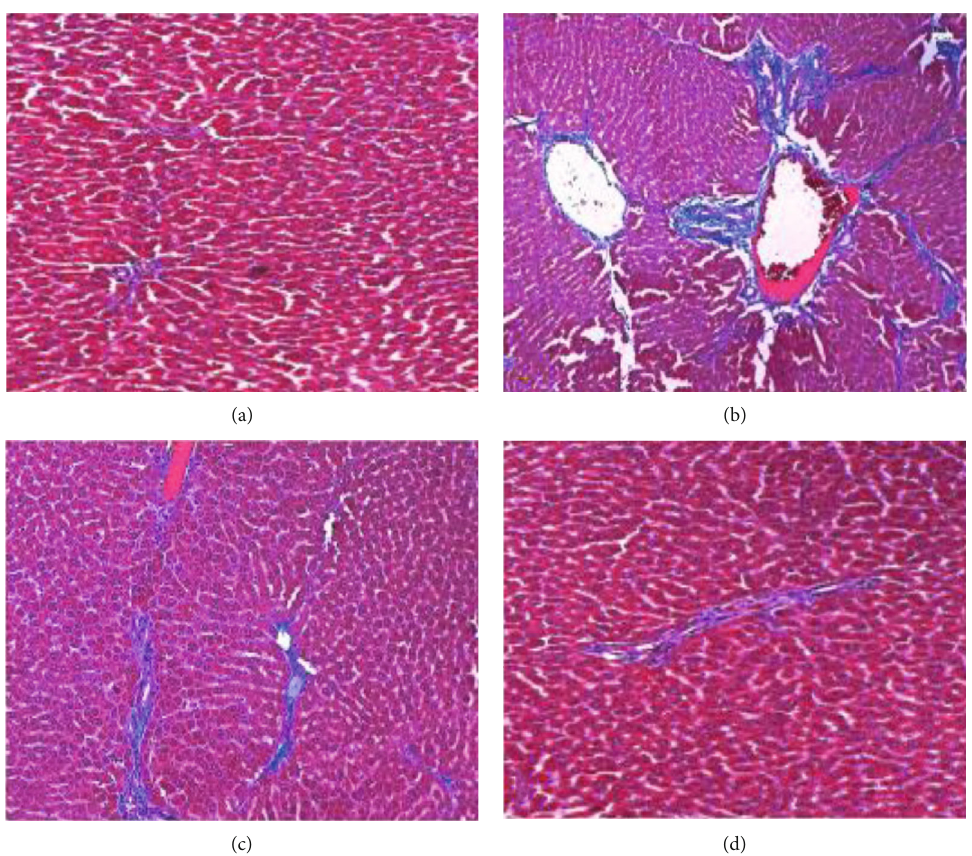
Figure 13: Masson trichrome staining analysis. Liver tissues showing the normal architecture of hepatocytes (a). DEN-only treated tissues showing signi fi cant collagen fi ber (b). 6-Gingerol plus DEN-treated tissue showed much lower collagen fi ber as compared to the DEN- treated group (c). 6-Gingerol-only treated group showed normal hepatocytes and less fi bers